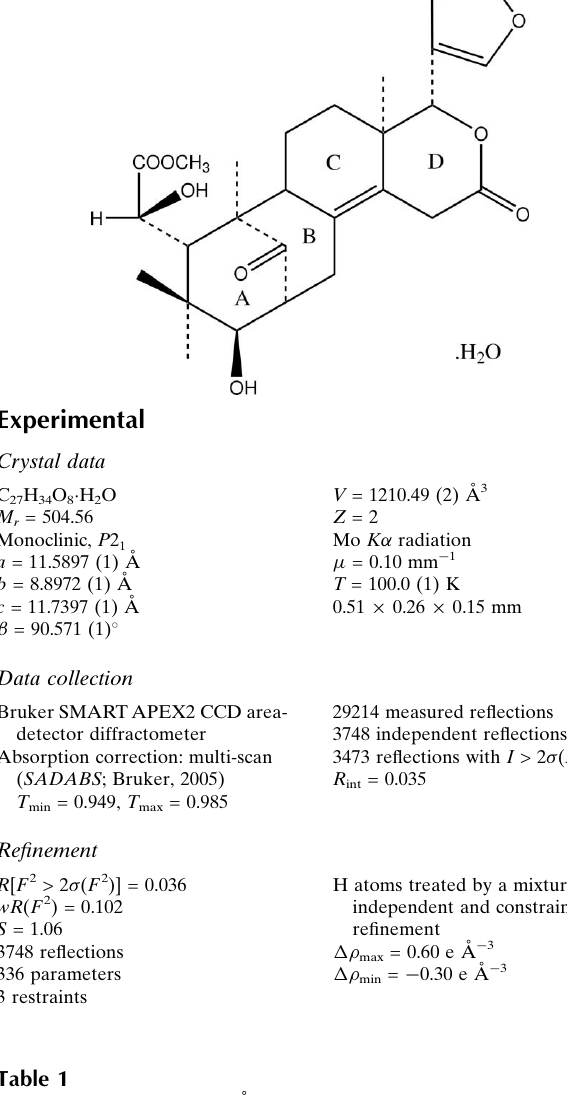
Hydrogen-bond geometry (A ˚ , (cid:2)